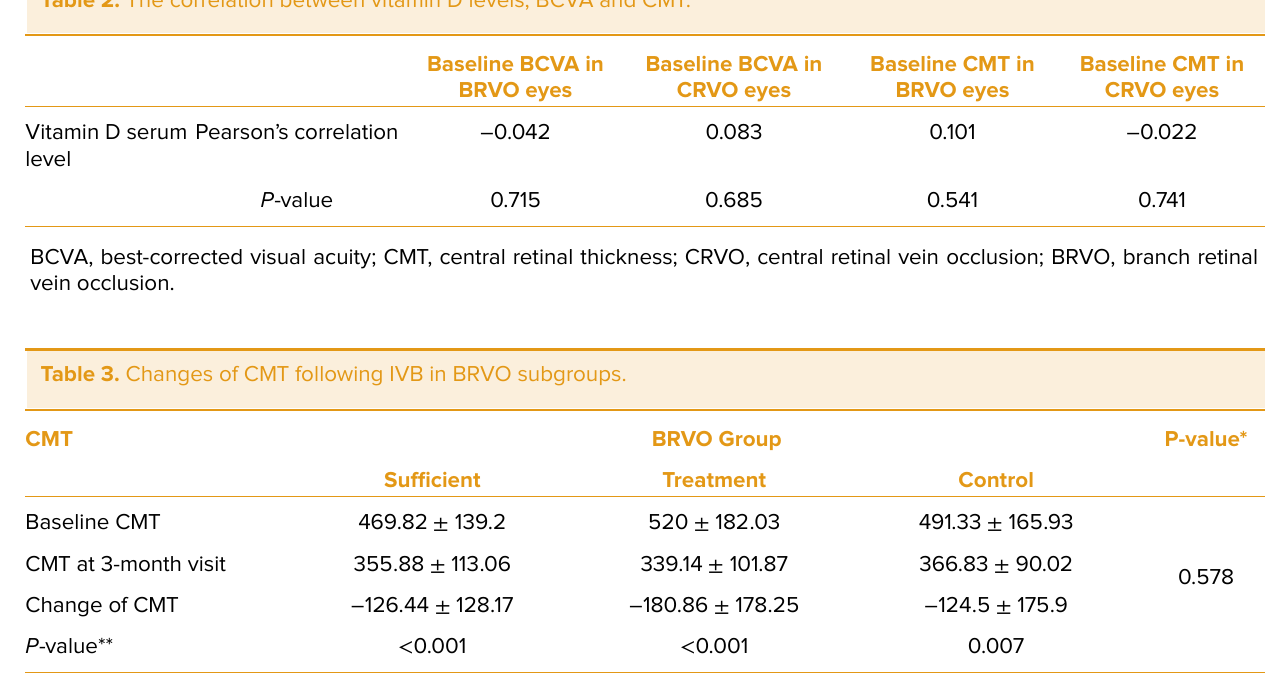
Table 2. The correlation between vitamin D levels, BCVA and CMT.